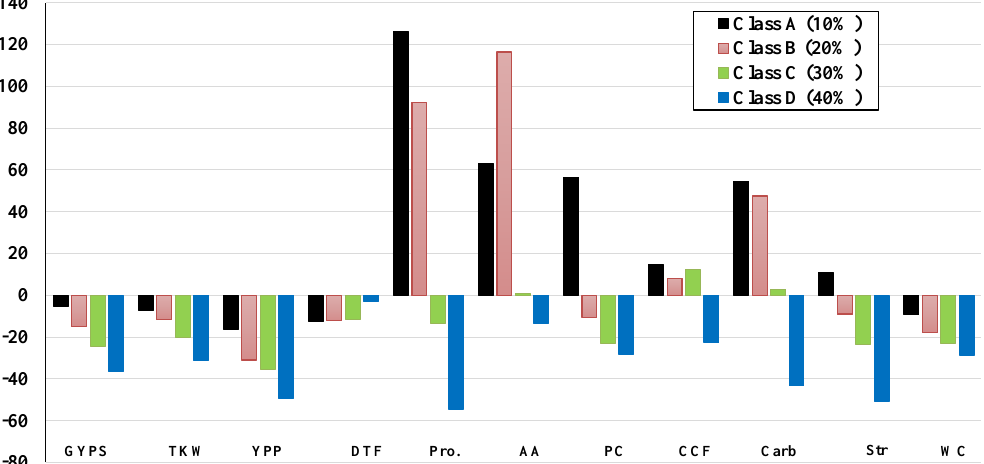
Figure 5. The percentage changes of all traits in the four classes; A (10%), B (20%), C (30%), and D (40%) under heat stress during pre-anthesis in barley.